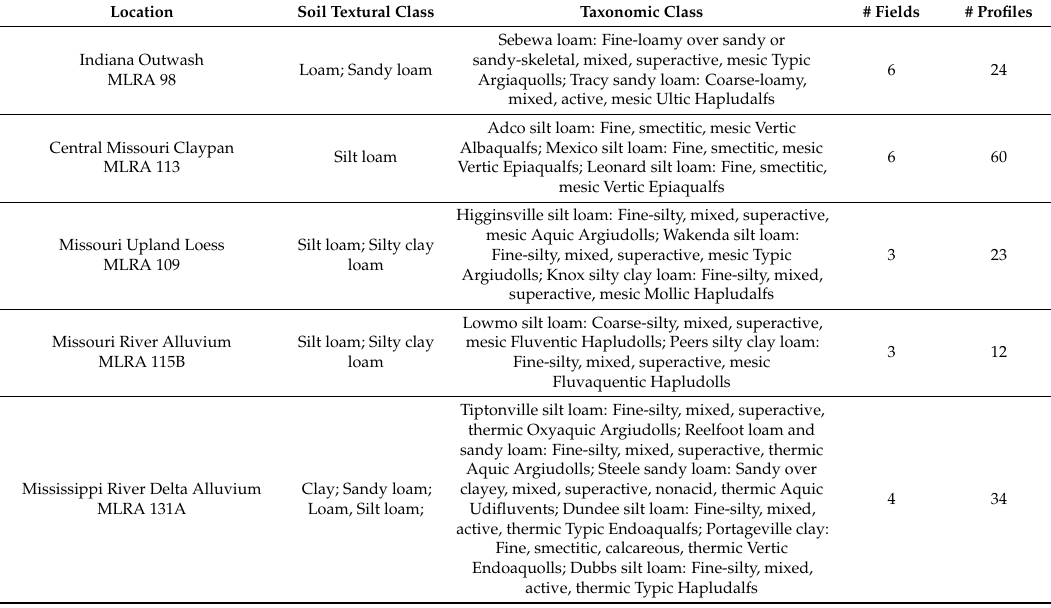
Table 1. Profile locations and soil descriptions of sampling locations in Missouri and Indiana by major land resource area (MLRA). In situ scans and soil cores were collected from each location (n = 153). Cores were split by horizon, resulting in 708 total